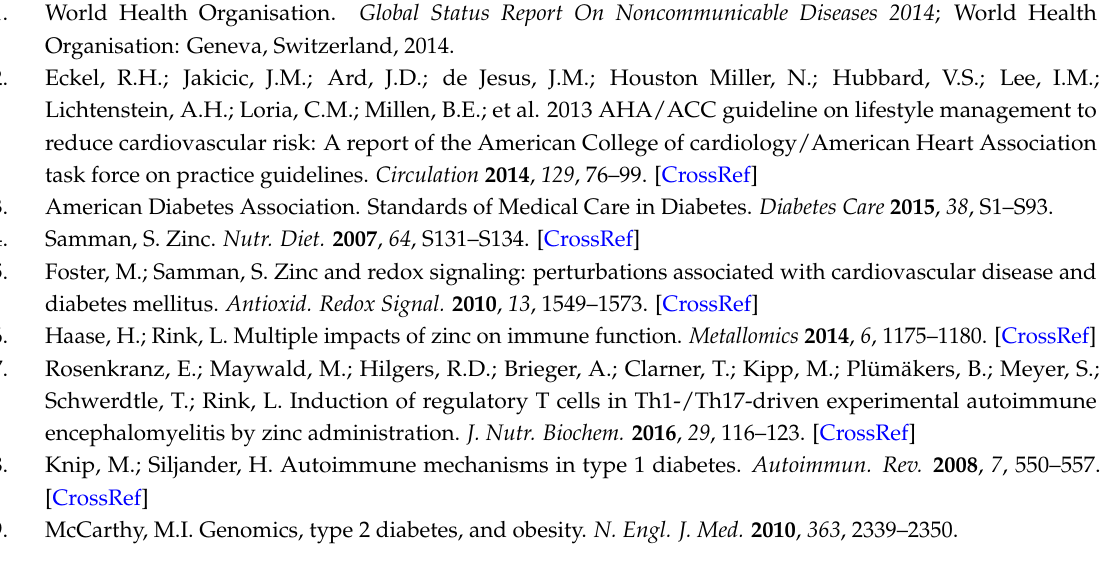
Table S1. Full search strategy used in EMBASE for the search terms (zinc AND [(dietary OR supplement*) OR (plasma OR serum)] AND diabetes), Table S2. Risk of bias assessment of included studies, Table S3. Scoring criteria of confounding factors and results of each individual study with models describing zinc intake and CVD outcomes, Table S4. Scoring criteria of confounding factors and results of each individual study with models describing serum zinc concentration and CVD outcomes, Table S5. Scoring criteria of confounding factors and results of each individual study with models describing zinc intake and Type 2 DM outcomes, Table S6. Scoring criteria of confounding factors and results of each individual study with models describing zinc intake and Type 2 DM outcomes, Table S7. Scoring criteria of confounding factors and results of each individual study with models describing serum zinc concentration and Type 2 DM